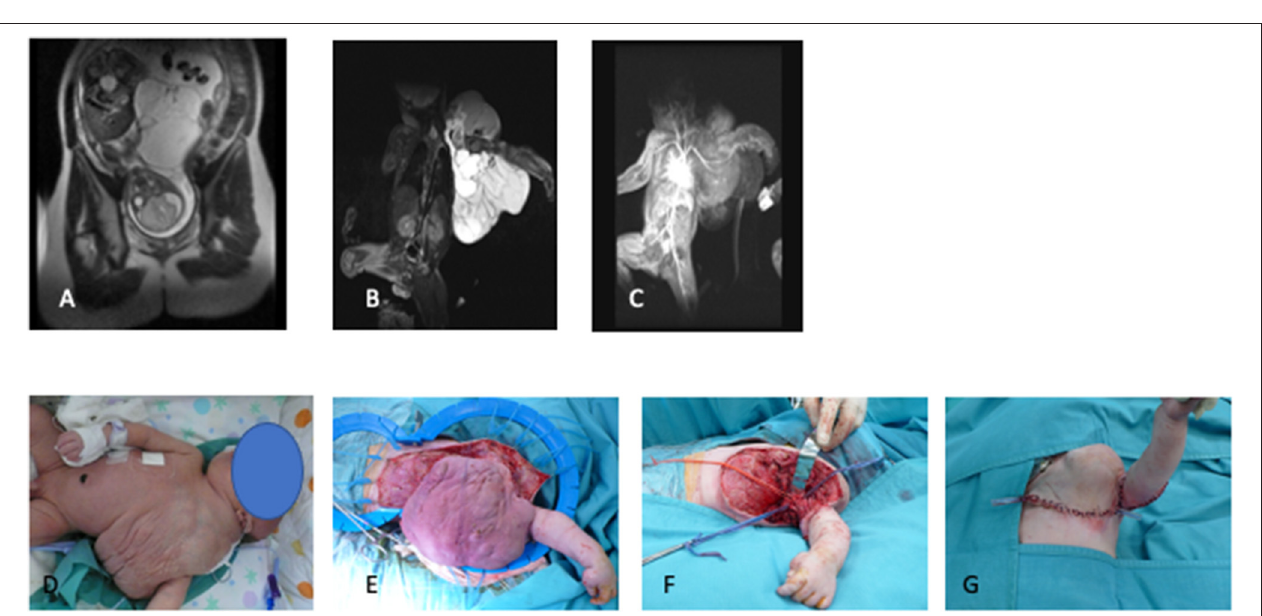
FIGURE 4 | (A) Fetal MRI, (B,C) postnatal T2-weighted MRI sequences, (D) preoperative appearance, (E,F) intraoperative dissection, (G) final surgical reconstruction.